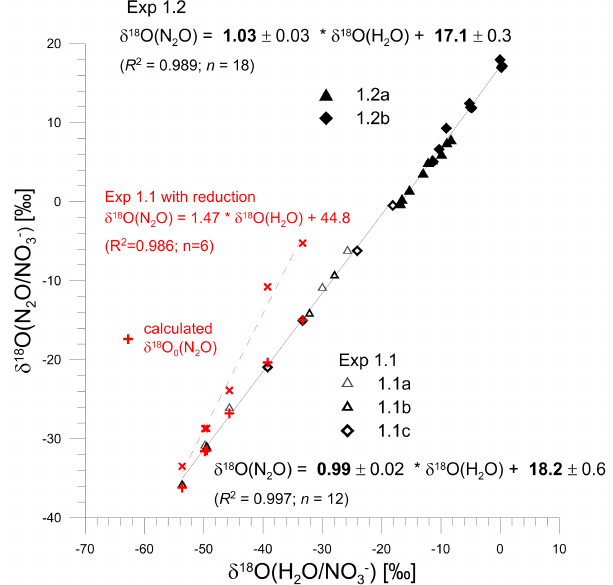
Figure 2. Correlation between oxygen isotopic signatures of N 2 O and soil water expressed in relation to soil nitrate, the equation of linear fit allows for estimation of isotope exchange with soil water (slope of the linear fit) and the associated isotope effect (intercept of the linear fit). In red the influence of N 2 O reduction on the method performance is presented – red “X” points represent the samples with not inhibited N 2 O reduction (note that the slope and intercept are very different), whereas the red “ + ” points stand for the same samples after mathematical correction of N 2 O reduction effect (as described in Sect. 2.5) which fit very well to the samples where N 2 O reduction was inhibited. Data from Exp